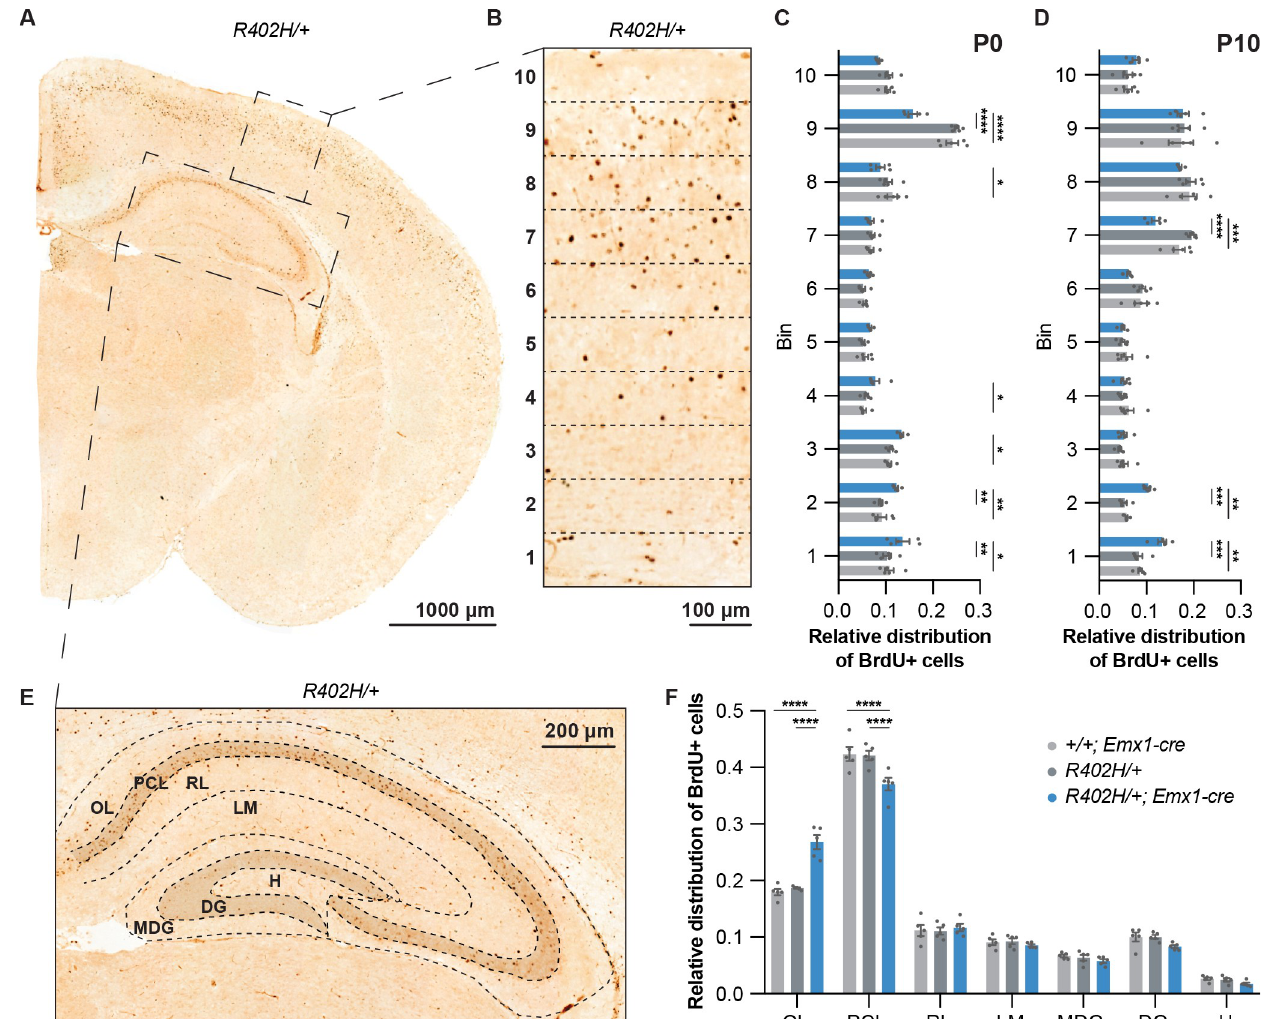
Fig 2. Neuronal migration defects in the cortex and hippocampus of R402H/+; Emx1-cre mice. BrdU was injected into pregnant dams at E14.5, and brains harvested at either P0 (n = 5) or P10 (n = 5). (A) Image of a P10 brain stained with antibodies that target BrdU. (B) Enlargement showing segmentation of the P10 cortex into 10 bins. (C) Graph showing the relative distribution of BrdU+ cells in the cortex of P0 control animals ( +/+; Emx1-cre in light grey and R402H/+ in dark grey) and heterozygous mutants ( R402H/+; Emx1-cre in blue). In R402H/+; Emx1-cre animals we noted a significant accumulation of BrdU+ cells in the deeper layers of the cortex (bins 1–4) concomitant with a decrease of BrdU+ cells in the upper layers (bins 8–9). (D) Relative distribution of BrdU+ cells across the cortex at P10. We found a significant increase in the proportion of BrdU+ cells in the deeper layers (bins 1–2) and a reduction in proportion of BrdU+ cells in bin 7. (E) Image showing the segmentation of a P10 hippocampus stained with antibodies that target BrdU. We quantitated BrdU+ cells in the oriens layer (OL), pyramidal cell layer (PCL), radiatum layer (RL), lacunosum moleculare (LM), molecular dentate gyrus (MDG), dentate gyrus (DG) and the hilus (H). (F) Graph showing the distribution of BrdU+ cells in the different layers of the hippocampus of P10 mice (n = 5). R402H/+; Emx1-cre mutants show a significant accumulation of cells in the OL, accompanied by a decrease in BrdU+ cells in the PCL in comparison to controls. Error bars show mean ± s.e.m. � P < 0.05; �� P < 0.01; ��� P < 0.001; ���� P < 0.0001 (See also S1 Table). Scale bars show 1000 μ m in A, 100 μ m in B and 200 μ m in